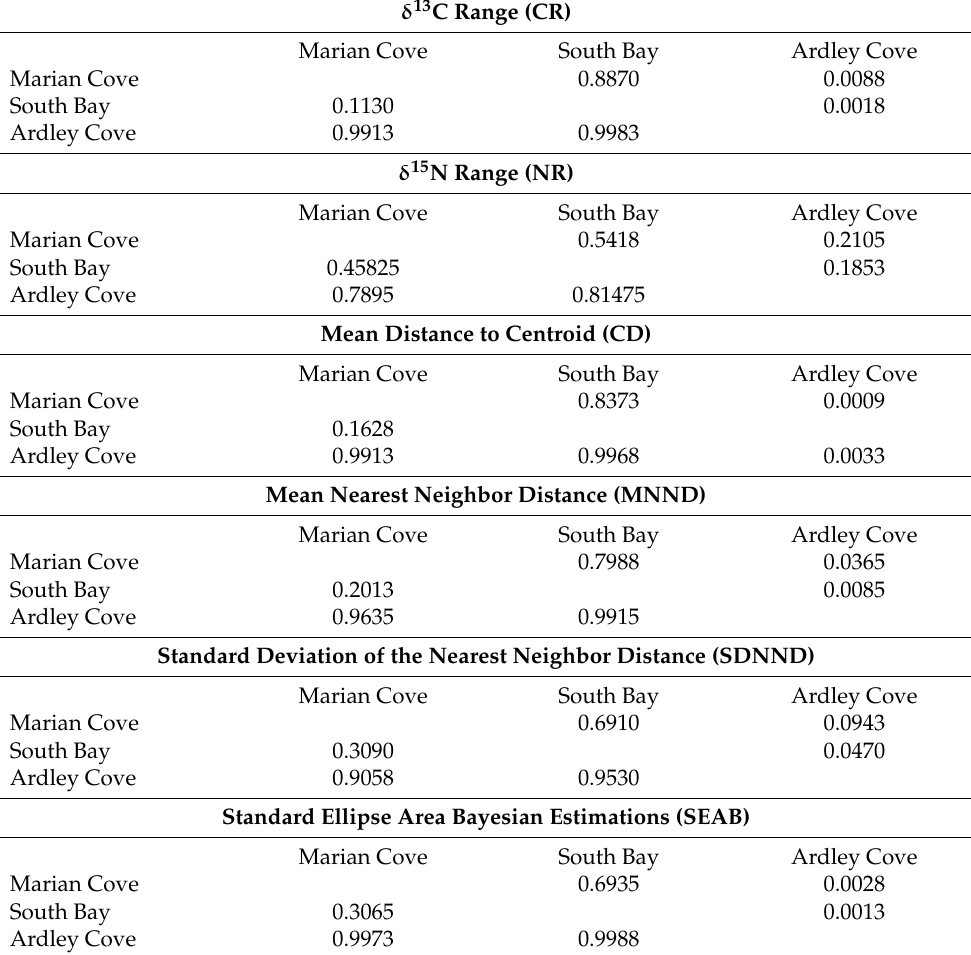
Figure 4. Density plot showing the 95, 75, and 50% credible intervals of Layman’s metrics in Marian Cove, South Bay and Ardley Cove using Bayesian techniques. Black dots represent the mean standard for each metrics; red dots indicate the mean of corrected metrics. Table 3. Probability that the Layman metric and isotopic niche width (SEAB) of the row is smaller than that of the column.